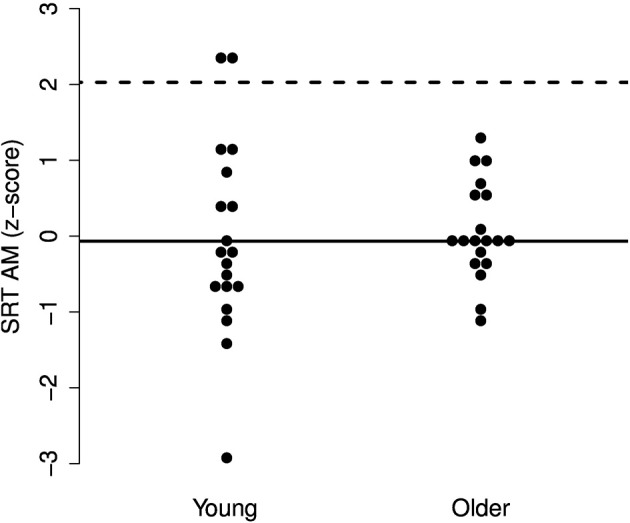
Individual z-scores for the SRTs in AM noise. The solid line indicates the mean for the young adults and the dotted line indicates the deviance threshold (1.65 SD above the mean for the young adults). No deviant older adults were identified.